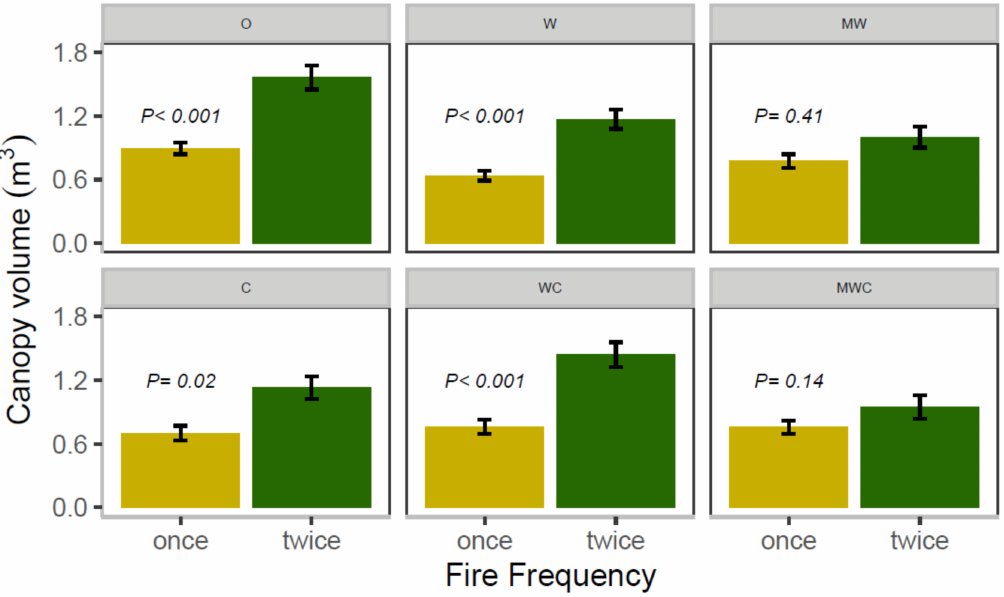
Figure 5. Differences in sapling/coppice growth (canopy volume) between plots burned once (2018) and plots burned twice (2013 and 2018). p values on top of the bars are obtained from all pairwise caparisons using emmeans in the R package emmeans